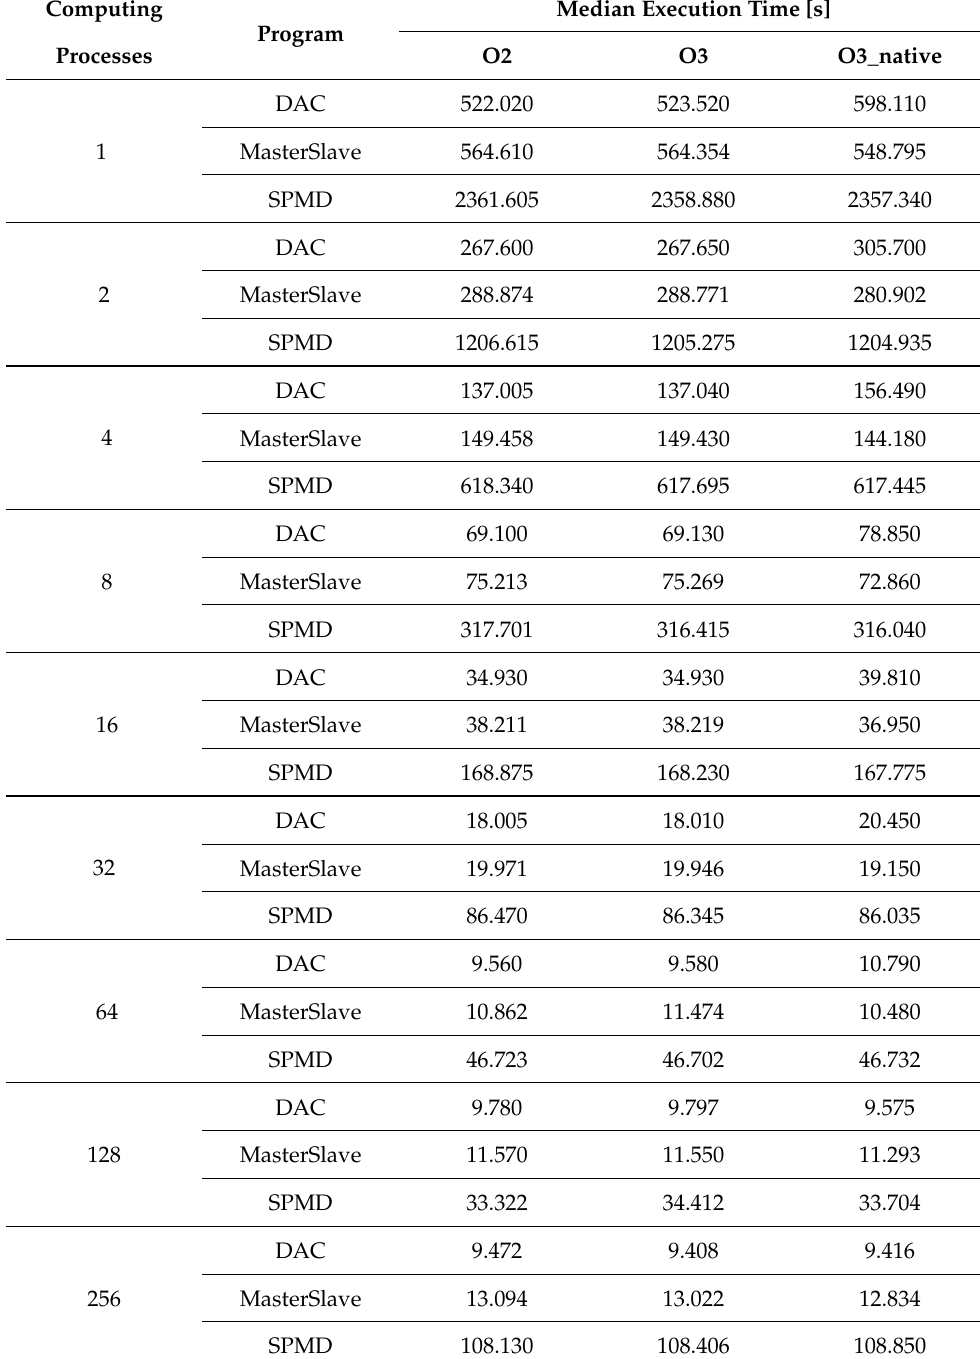
Table 4. Median execution time for each parameters, programs and computing